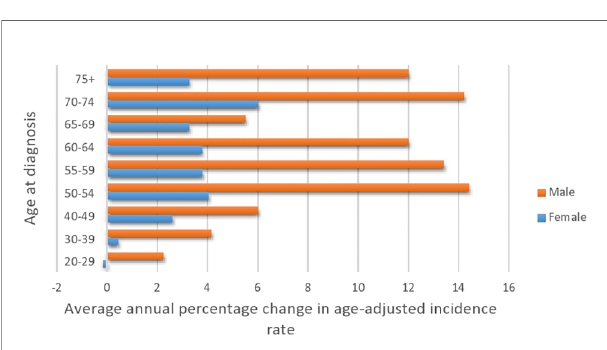
FIGURE 2 | Average annual percentage change in colorectal cancer by age at diagnosis and gender (2001 –